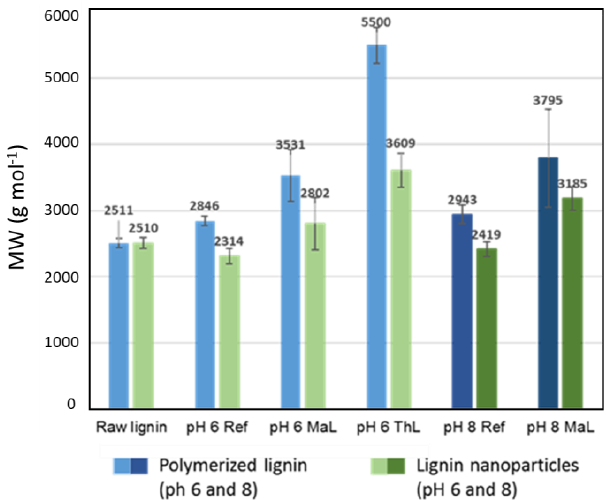
Figure 3. Average molecular masses and standard deviations of the enzymatically oxidized and polymerized lignins. Molecular masses were analyzed also for the CLPs prepared from the enzymatically treated lignins. The smaller values of dissolved CLPs are most likely due to slower solubility of CLPs in alkaline reaction conditions than powdered lignin. Table 1. Characterization of CLPs prepared from laccase-treated